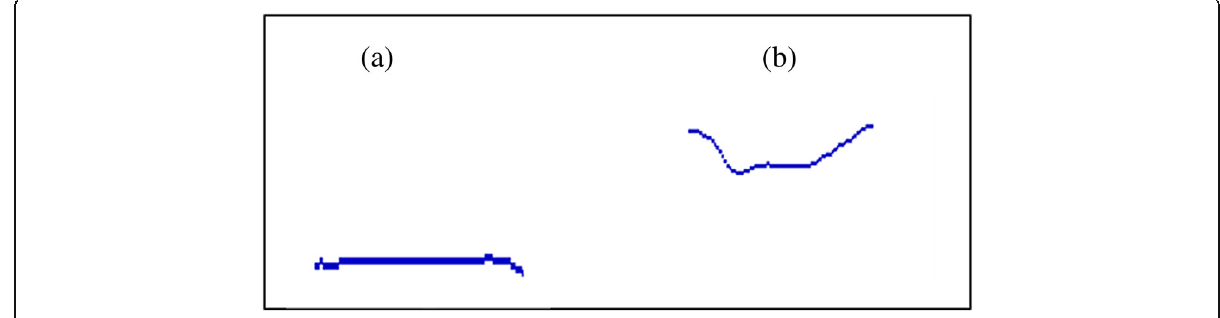
Fig. 3 Comparison of the nasalance slope between Vietnamese hyponasality ( a ) and hypernasality ( b ) cleft palate